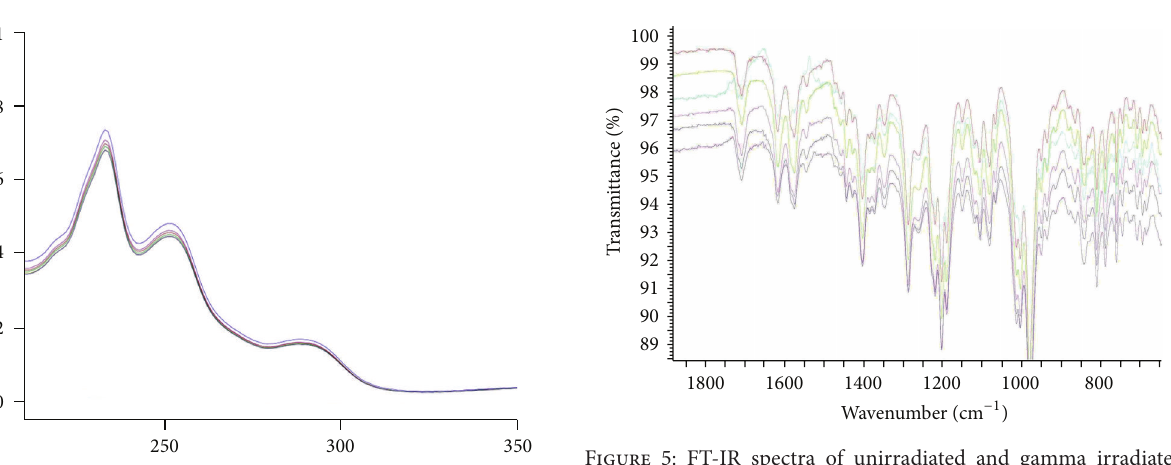
Figure 5: FT-IR spectra of unirradiated and gamma irradiated